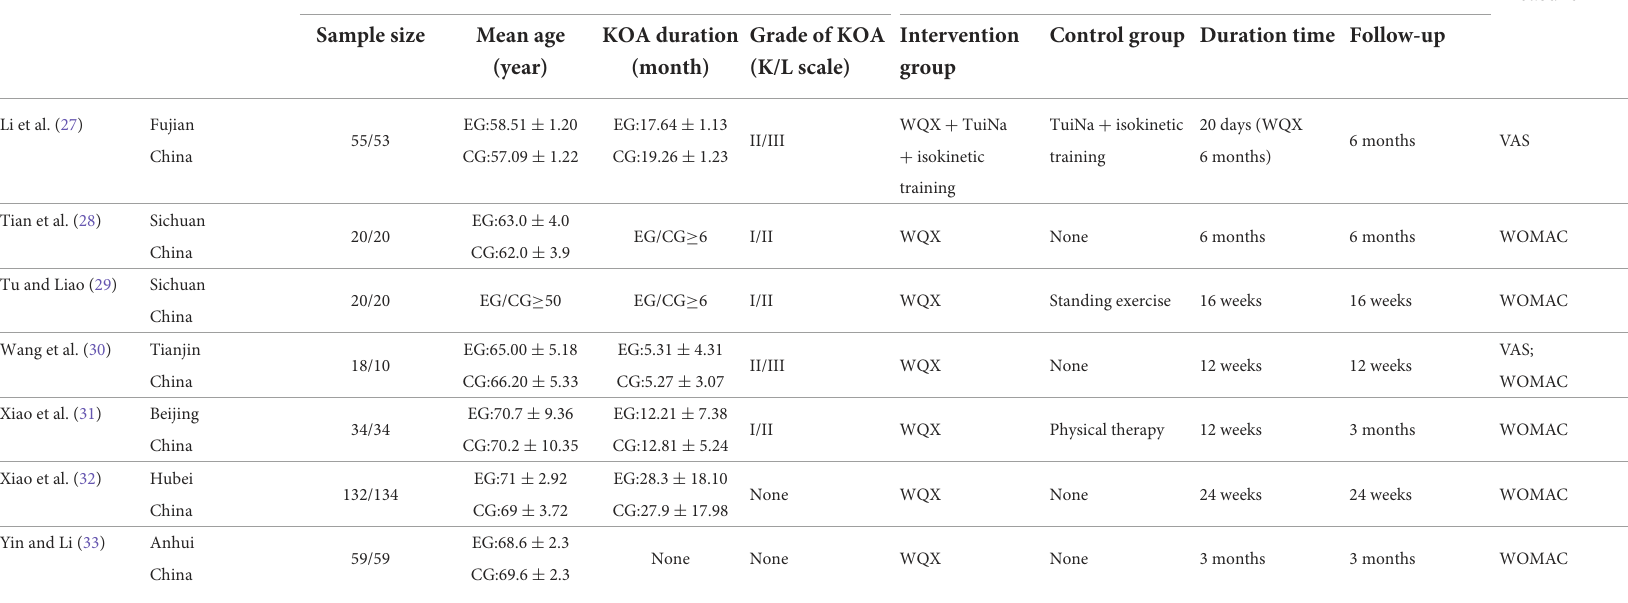
TABLE 1 Characteristics of data extracted from the included